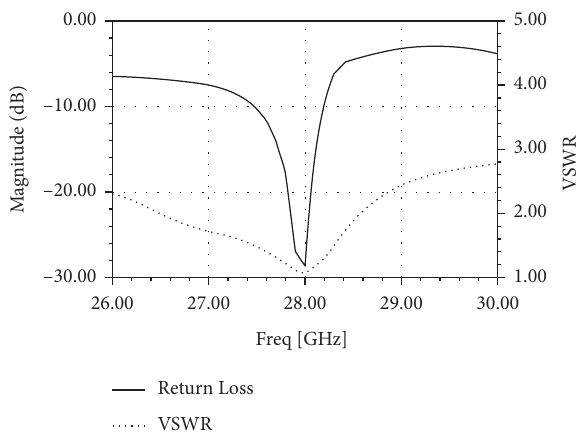
Figure 8: Proposed 34 elements thinned array antenna simulation results of return loss (S11) and VSWR.